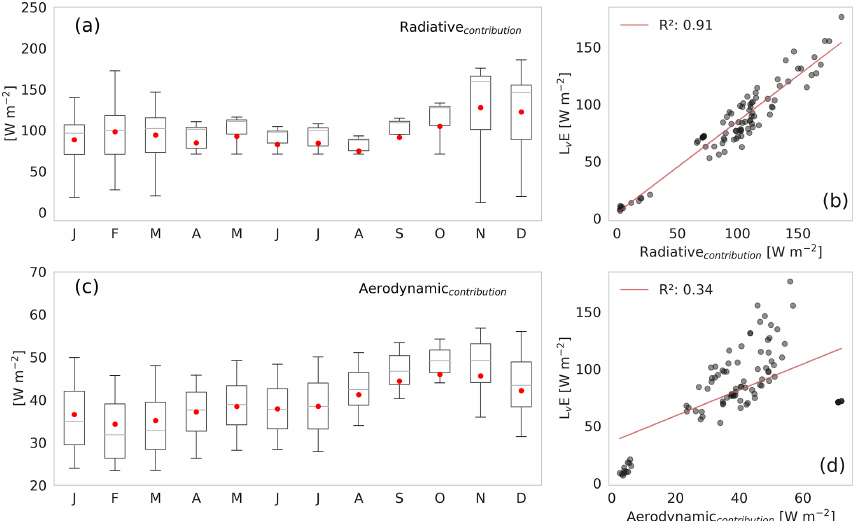
Figure 8. (a, c) Seasonal variability of radiative and aerodynamic contribution to evaporation during the period 1950–2020. The boxes represent 25%–75% interquartile, the gray horizontal line is the median, the red dots are the mean and bars represent maximum and minimum values. Outliers have been removed. (b, d) Orthogonal regression of evaporation rates and its energy and aerodynamic contribution at averaged monthly